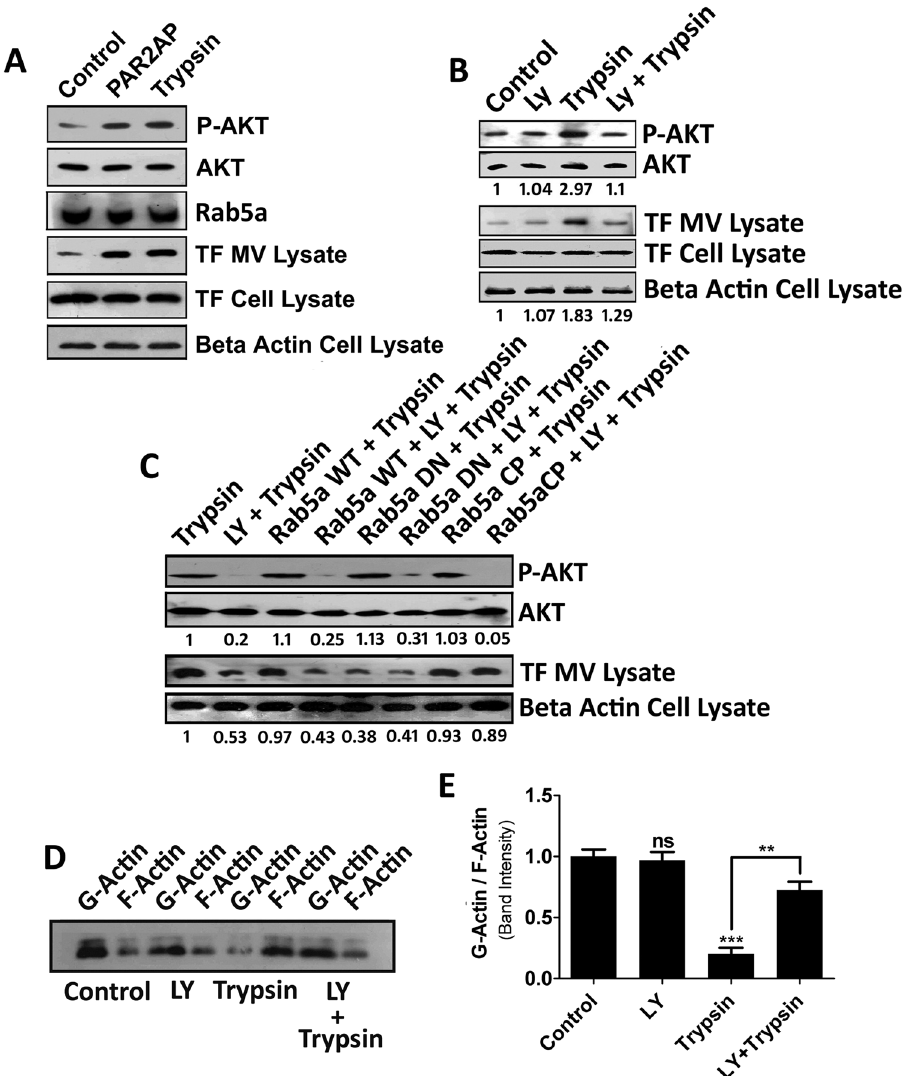
Figure 4. Trypsin Mediated Rab5a Activation Leading to MVs Generation Occurs via Intracellular Activation of AKT. Cells were treated with PAR2AP (100 µ M) and trypsin followed by an incubation of 10 minutes and the phosphorylation of AKT was analyzed by western blotting. Subsequent MVs generation was quantified 24 hours later by western blotting with MVs marker, TF ( A ). Cells were serum starved for an hour followed by treatment with LY294002 (25 µ M). An hour later trypsin was added and both AKT phosphorylation as well as MVs generation was quantified by western blotting ( B ). Cells were transfected with various forms of Rab5a followed by LY294002 and trypsin addition. Both AKT phosphorylation as well as MVs generation was estimated by western blotting to assess the chronology of activation ( C ). Cells were challenged with LY294002 followed by trypsin treatment and G-/F-actin ratio was quantified to determine the effect of AKT activation on actin polymerization ( D ) and ( E ). Data presented over here are as Mean + / − S.E. of the Mean and differences are statistically significant at p < 0.05 using student’s t-test after performing the experiments